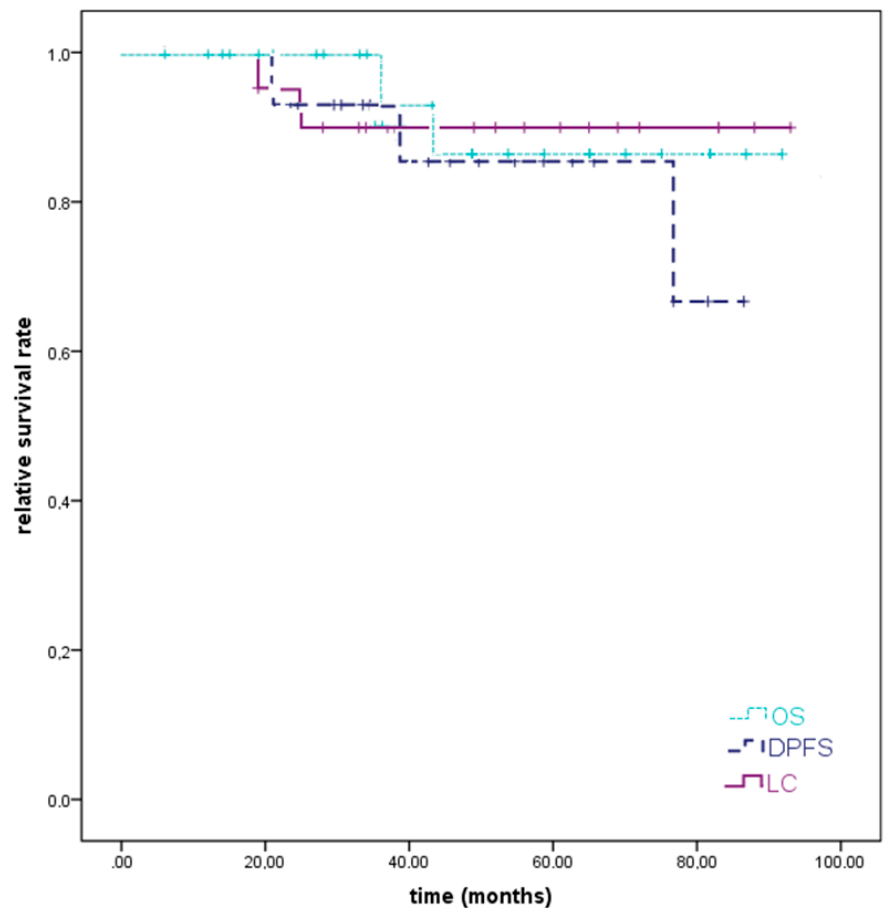
Figure 3. Kaplan–Meier estimates for local control (LC), distant progression-free survival (DPFS), and overall survival (OS). A 2-year LC, DPFS, and OS of 95%, 93%, and 100% and an estimated 5-year LC, DPFS, and OS of 90%, 86%, and 86% could be assessed for high-risk nasopharyngeal cancers after bimodal radiotherapy (RT).